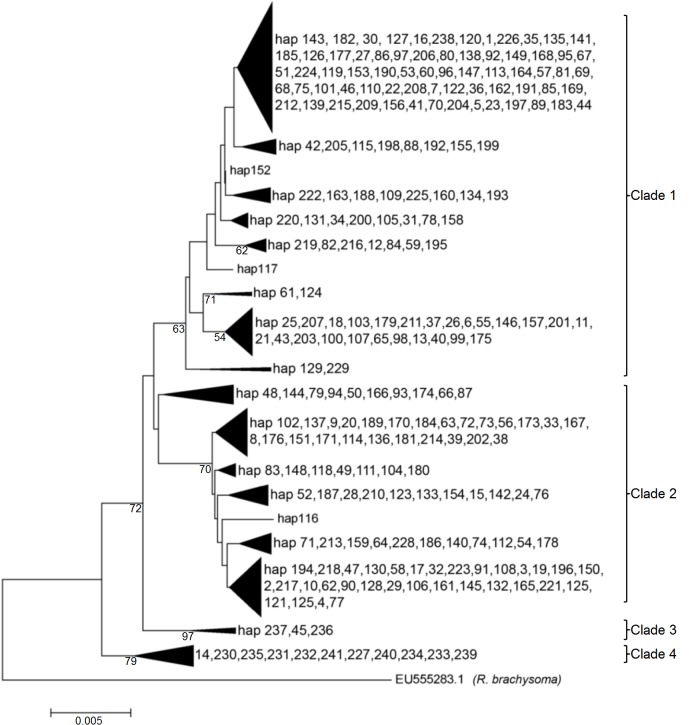
Evolutionary history as inferred using the Neighbor-Joining method (K2P distance) with 1000 bootstrap replicates.